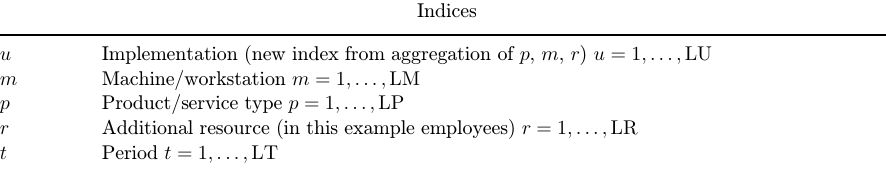
Table B.1. The decision variables, indices and constraints of the transformed model for the illustrative example.